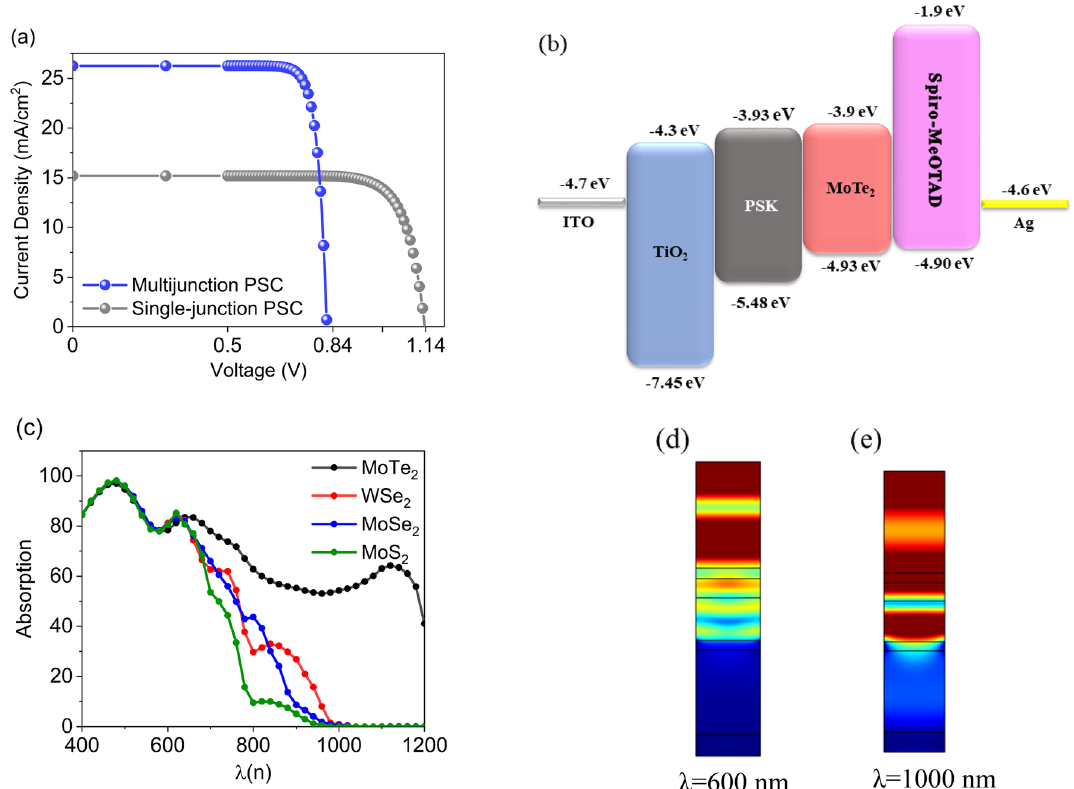
Figure 2. The single and multijunction PSC performance. ( a ) Current density–voltage (J–V) curve of the single PSC and multijunction PSC including MoTe 2 . ( b ) The band alignment diagram of multijunction PSC. ( c ) The absorption spectra of the structure for different TMDs including MoTe 2 , WSe 2 , MoSe 2 , and MoS 2 . ( d ) and ( e ) The normalized electric field distribution at the wavelengths of 600 and 1000 nm,